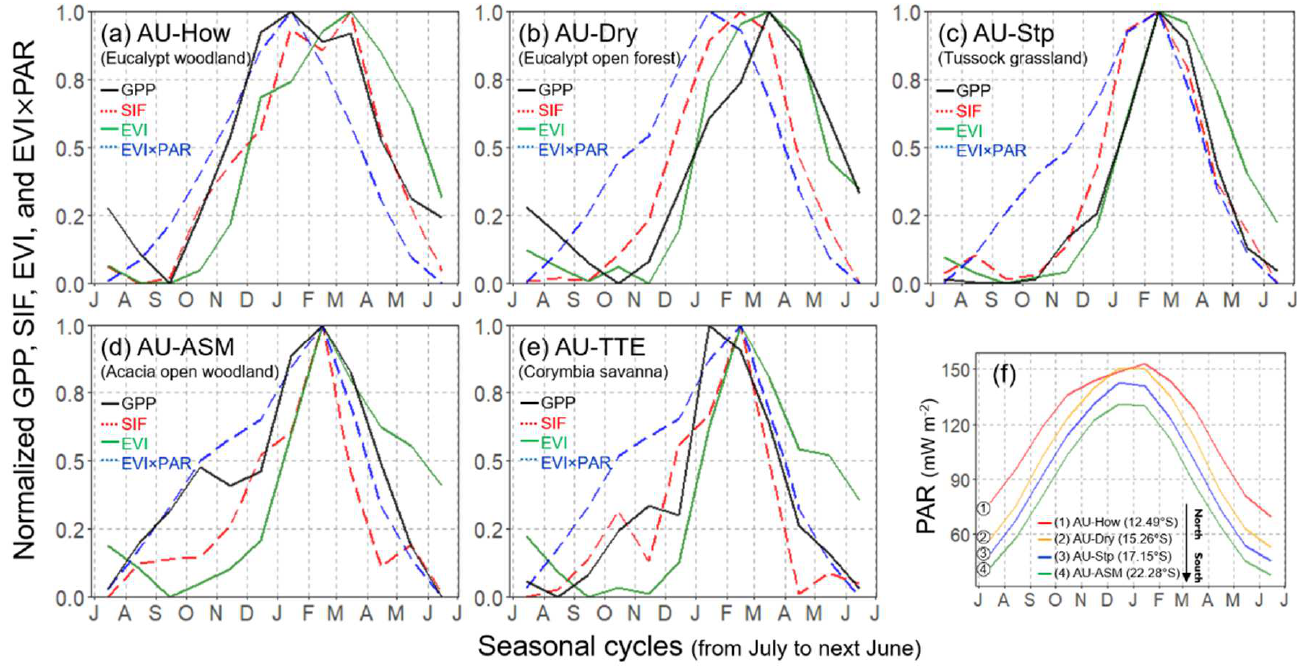
Figure 4. ( a – e ) Seasonal cycle (mean) of tower-based GPP, GOME-2 SIF, MODIS EVI, and EVI × PAR over 5 selected local sites during 2014–2019. Curves are normalized with respect to unity at the maximum annual value. ( f ) Seasonal cycle (mean) of PAR over 5 selected local sites during 2014–2019. Satellite observations were extracted within a 3 × 3 window centred at each flux tower site (SIF: 1.5° × 1.5°; EVI and EVI × PAR: 0.15° × 0.15°). The differences of key phenological metrics (SOS and EOS) derived from satellite- observed SIF and EVI as compared with tower-based GPP over five flux tower sites during 2014–2019 are presented in Table 1. For SOS over three northern sites (AU-How, AU-Dry, and AU-Stp), the mean absolute errors (MAE) of both SIF and EVI ranging from 7 to 32 days were generally less than those over two southern arid sites (AU-ASM and AU-TTE, ranging from 31 to 54 days). On the contrary, there was a larger discrepancy in EOS at AU-How and AU-Dry (MAE ranges from 39 to 60 days). Besides, for two southern sites (AU-ASM and AU-TTE), the differences of EOS between EVI and GPP were notably larger than those between SIF and